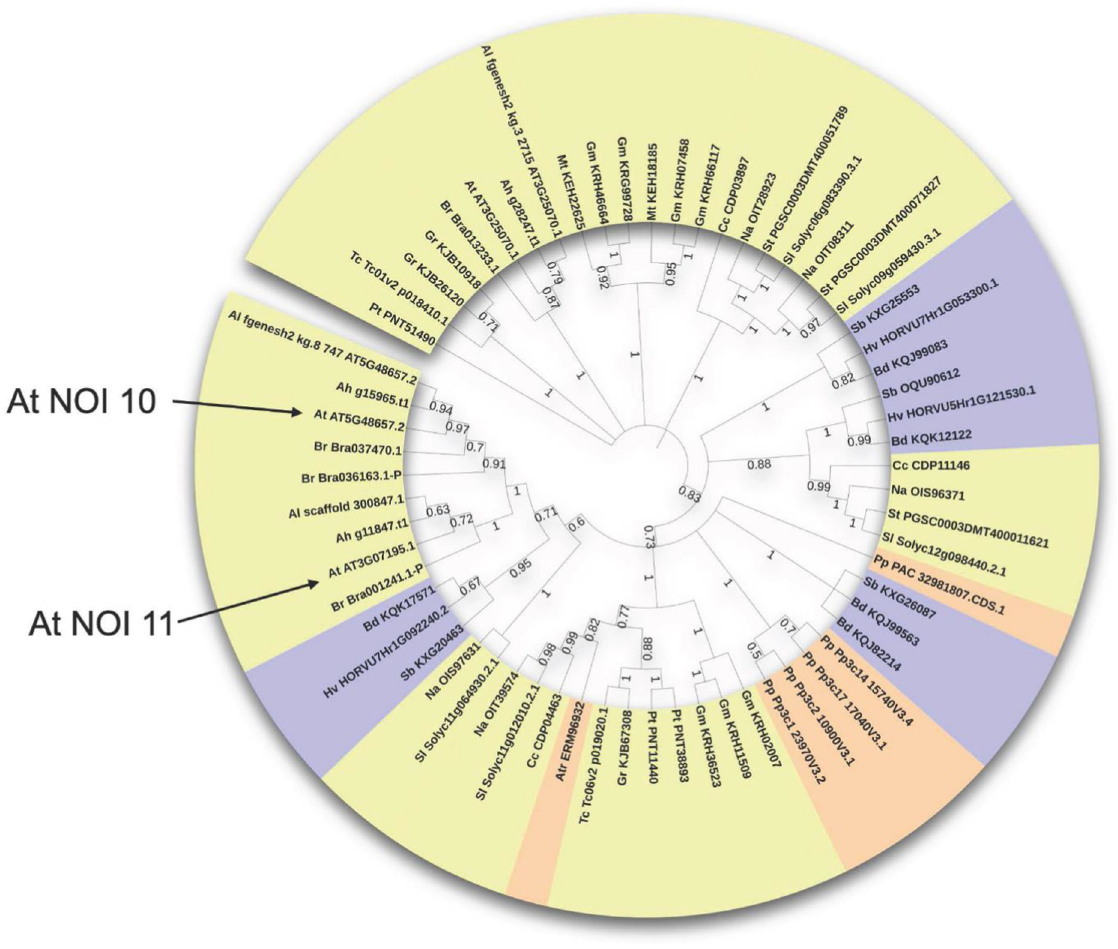
Fig 1. Phylogenetic tree of RIN4-like/NOI family long two-NOI proteins. Dicot labels are shown in yellow, monocot in purple, and PAS sequences in orange. The position in the tree of A . thaliana RIN4-like/NOI members upregulated after mite feeding is indicated. Branches are collapsed at 50% bootstrap, values higher than 50% are